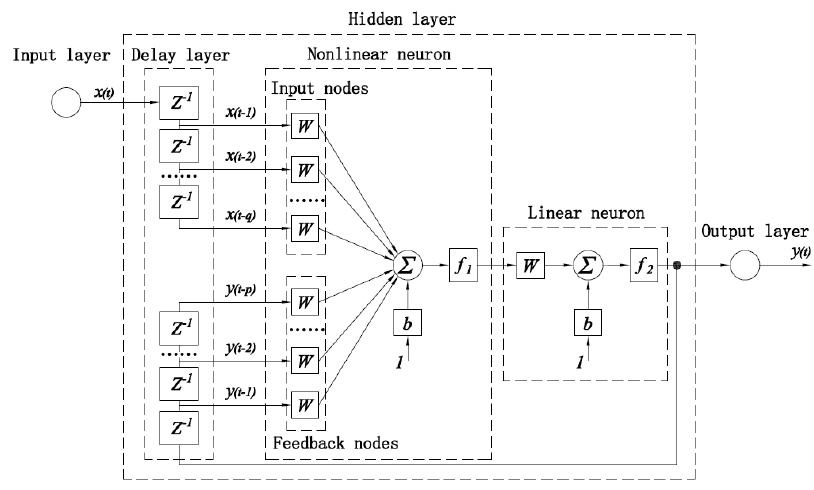
Figure 1. Structure of the time-delay recurrent neural network (TDRNN).